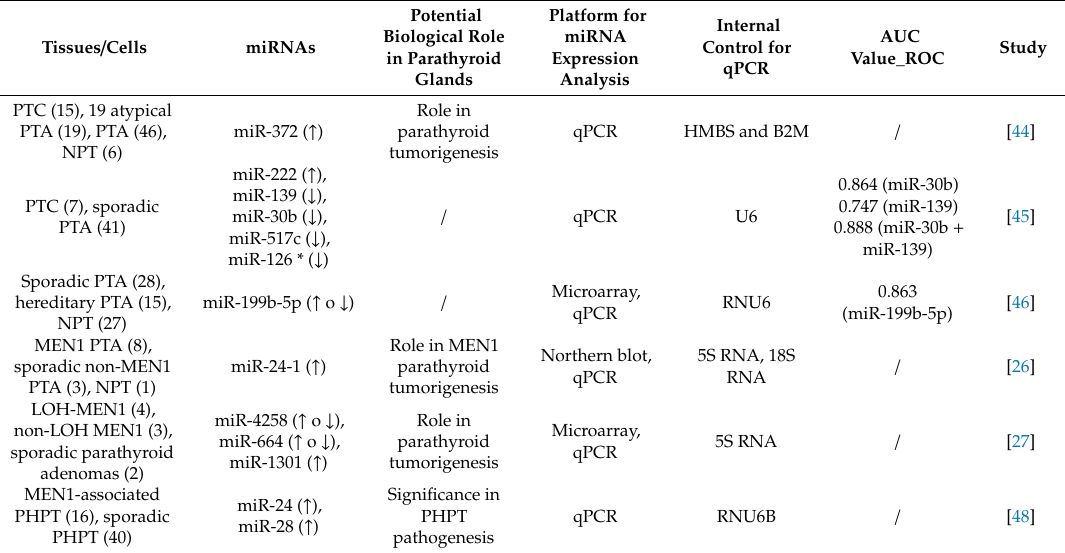
* Tissues isolated from patients are shown in parentheses. Table 1 footnotes: PTA = parathyroid adenoma; PHPT = primary hyperparathyroidism; PTC = parathyroid carcinoma; PHPT = primary hyperparathyroidism; NPT = normal parathyroid; MDG = multiple gland